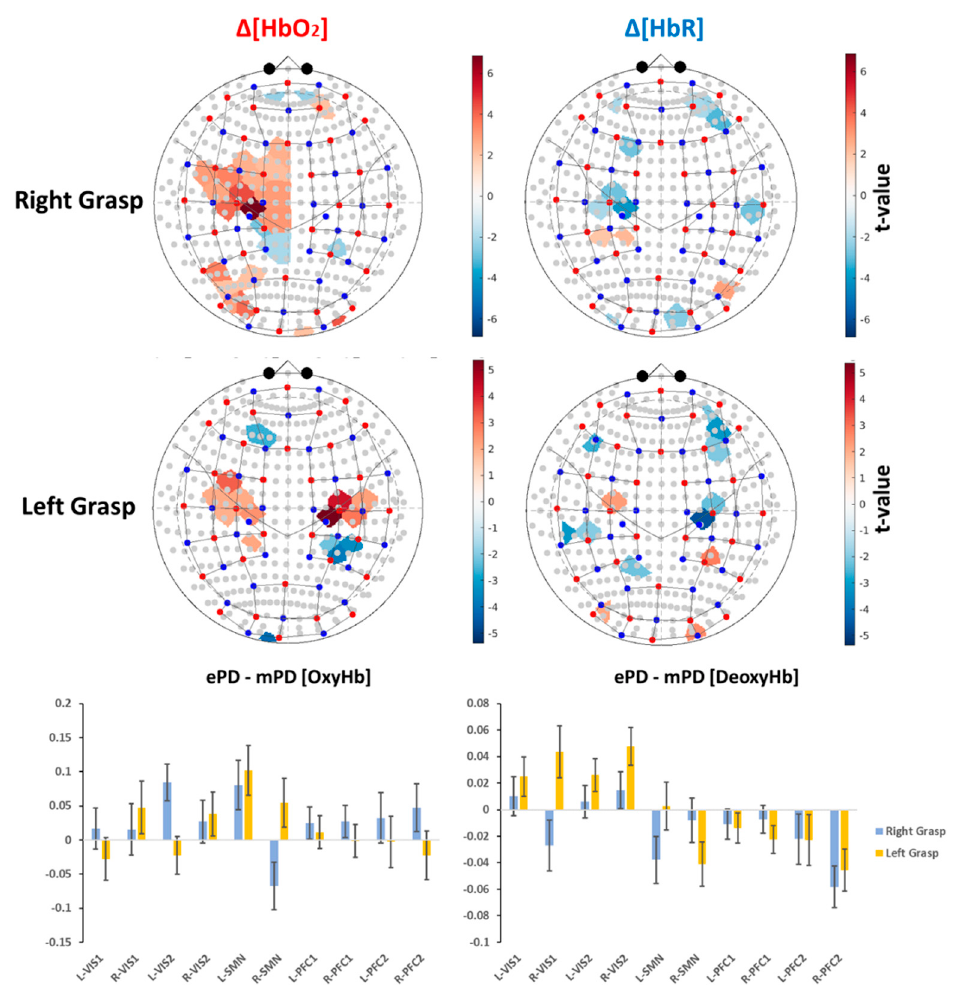
Figure 3. ( Top ) Significant group-level contrast activation maps for the ePD and mPD groups. Results were not corrected for multiple comparisons ( p < 0.05). Positive t value indicates a greater activation in the ePD group than in the mPD group. Table 3. Significant group-level contrasts between the ePD vs. mPD groups across ROIs, task con- ditions, and chromophores. Bold highlights significant comparisons.